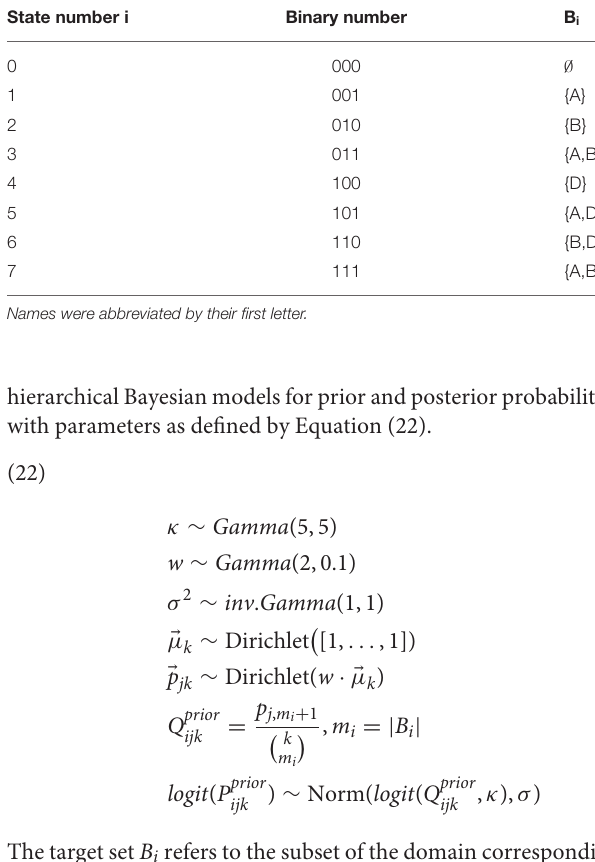
TABLE 2 | Binary encoding of subsets of individuals for the domain consisting of { Audrey,Bob,Dale } . State number i